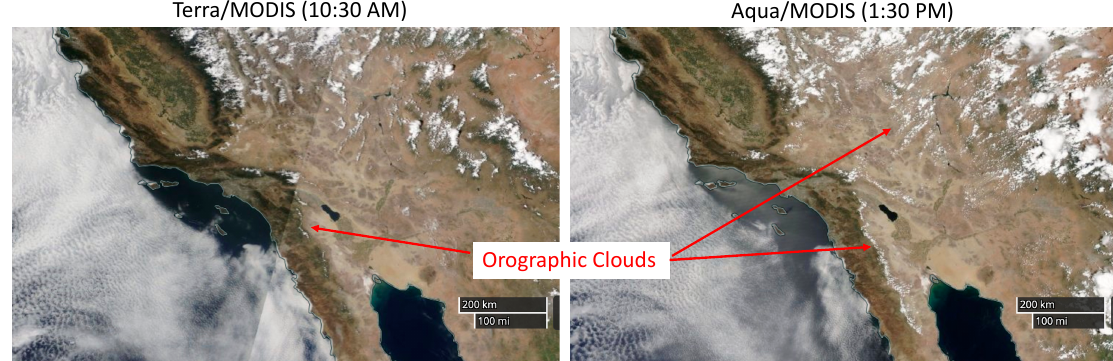
Figure 30. Orographic cloud development seen by MODIS between morning and afternoon on 26 July 2019 over California, Arizona, and Mexico.